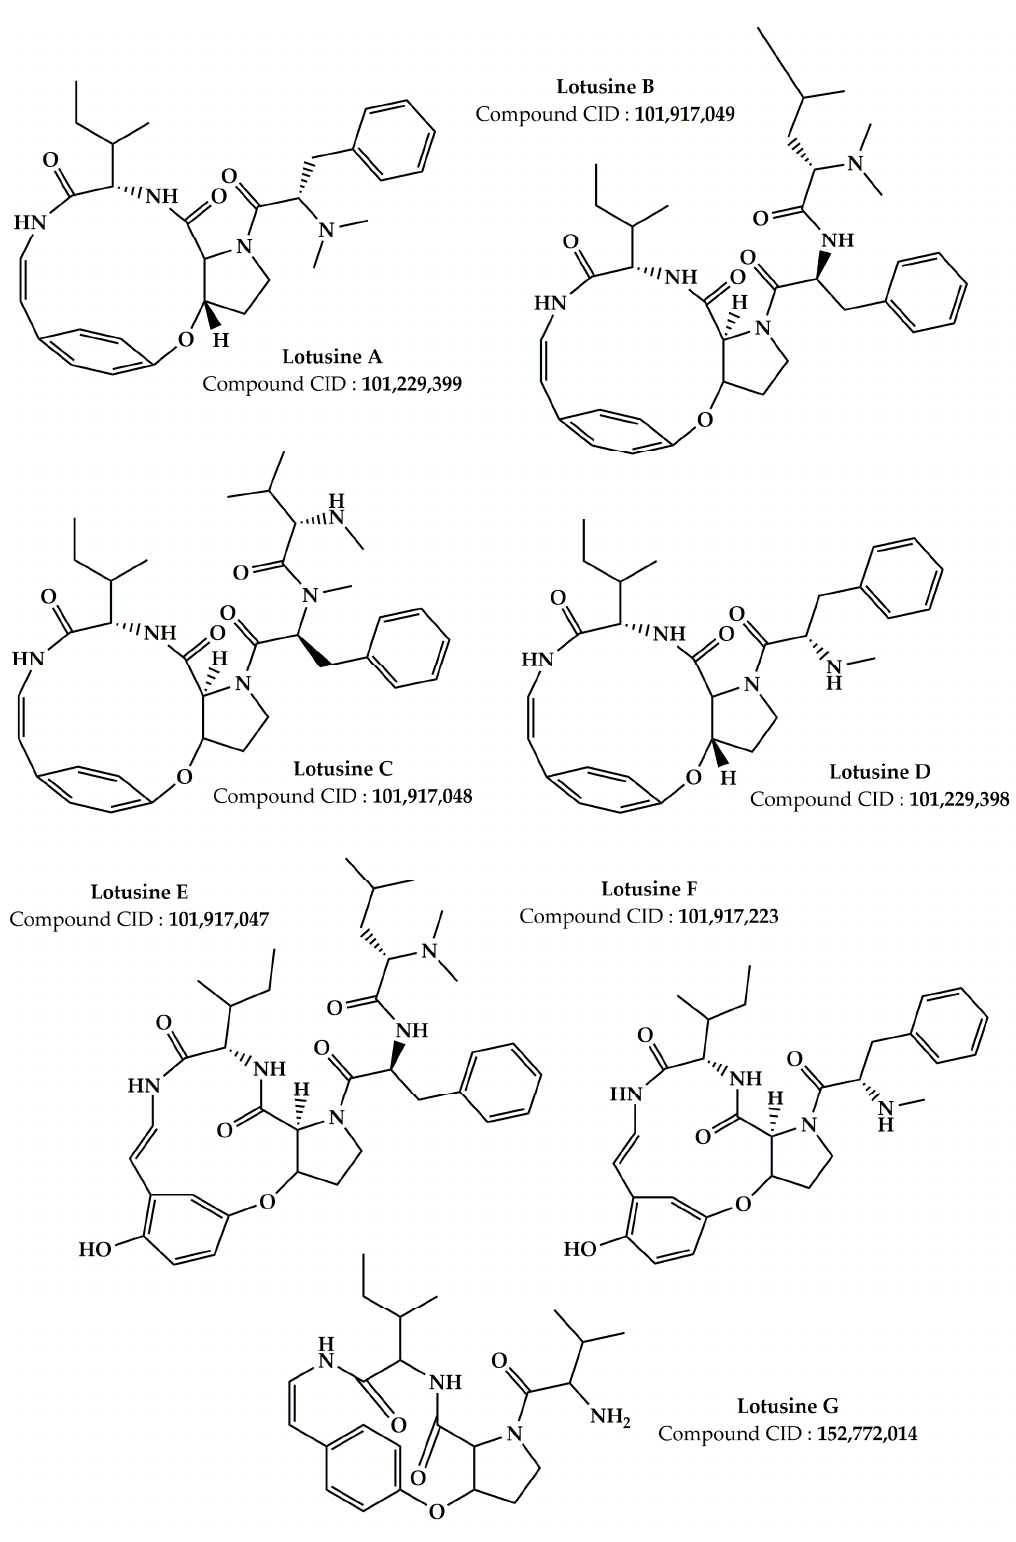
Figure 6. Chemical structures of the alkaloid compounds identified in Z. lotus . Comparatively, we observed that the chemical composition of Z. lotus extracts varied from one country to another. This variation in the chemical composition between identical Z. lotus extracts from other countries may be provoked by a variety of elements including the collection’s origin, the climate during the harvest, the harvest season, and the